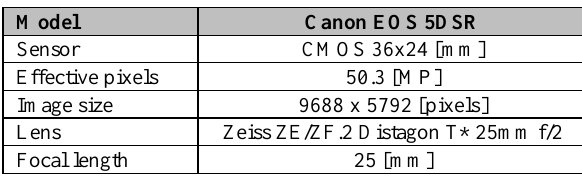
Table 1. Main specifications of Canon EOS 5DSR camera.